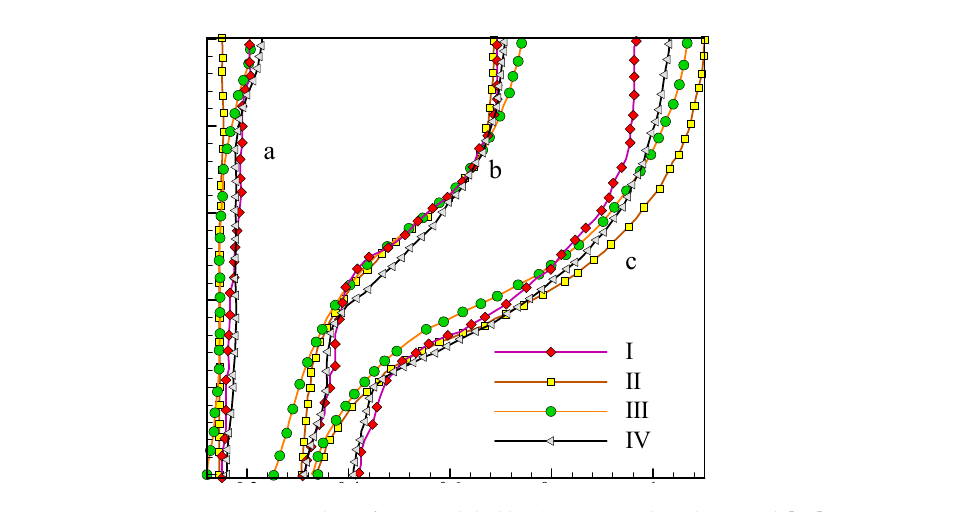
Figure 3. Melting front modeled by I) Numerical Kashani et al. [32] II) Experiment Gau and Viskanta [33],